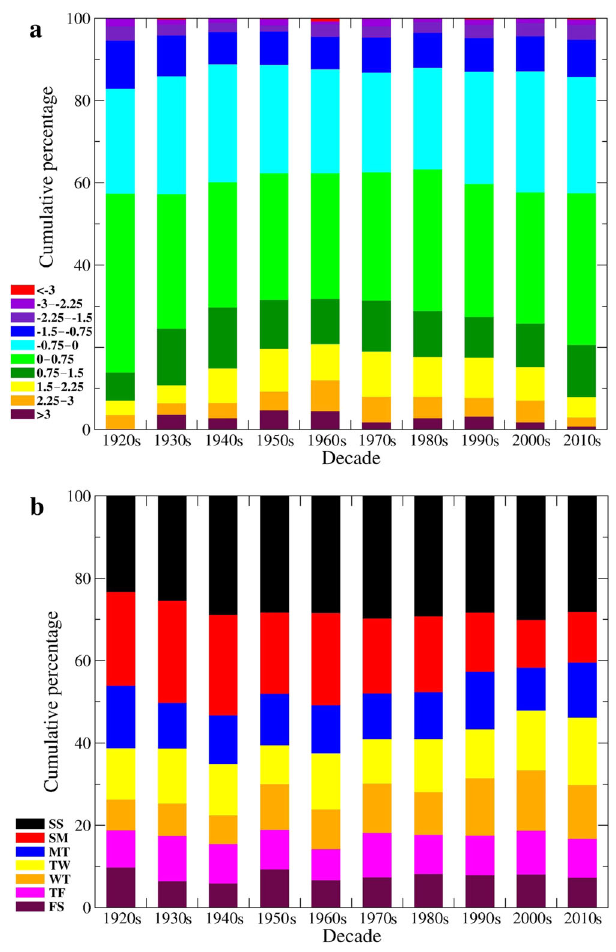
Fig. 5 Decadal cumulative percentage of sites falling within one of 10 WHI bins and one of seven two-day combinations of low fl ows, respectively, across the USA and Canada. In ( a ), WHI bins match those used in Fig. 4 with a similar color palette (e.g., the maroon bars indicate WHI ≥ 3.0 starting at a zero cumulative percentage). In ( b ), the two-day combinations with low fl ows start on Friday/Saturday (FS) at a zero cumulative percentage (maroon bars) and end on Saturday/Sunday (SS) at 100% (black